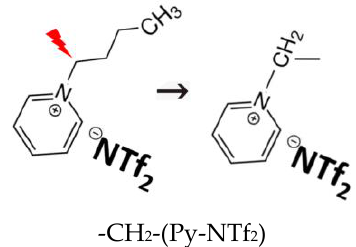
Figure 3. The development of the “centerpieces” for calculating the vaporisation enthalpies of